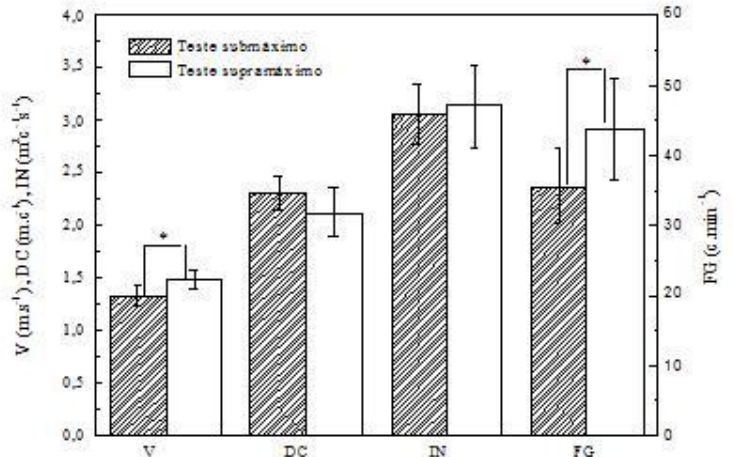
Figura 2. Média e desvio-padrão da velocidade de deslocamento do centro de massa (V), da distância de ciclo (DC), da frequência gestual (FG) e do índice de nado (IN), durante os testes submáximo e máximo (*p<0,05).